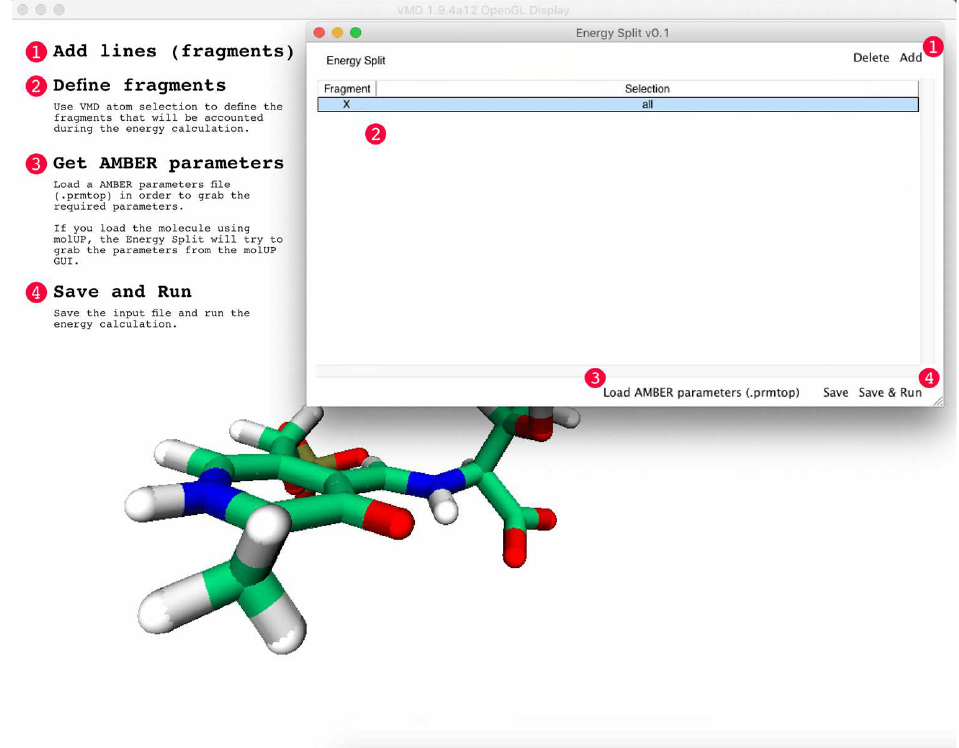
Figure 3. Screen shot of the Energy Split extension for VMD. The labeled numbers and associated text provide instruction on how to use the extension.